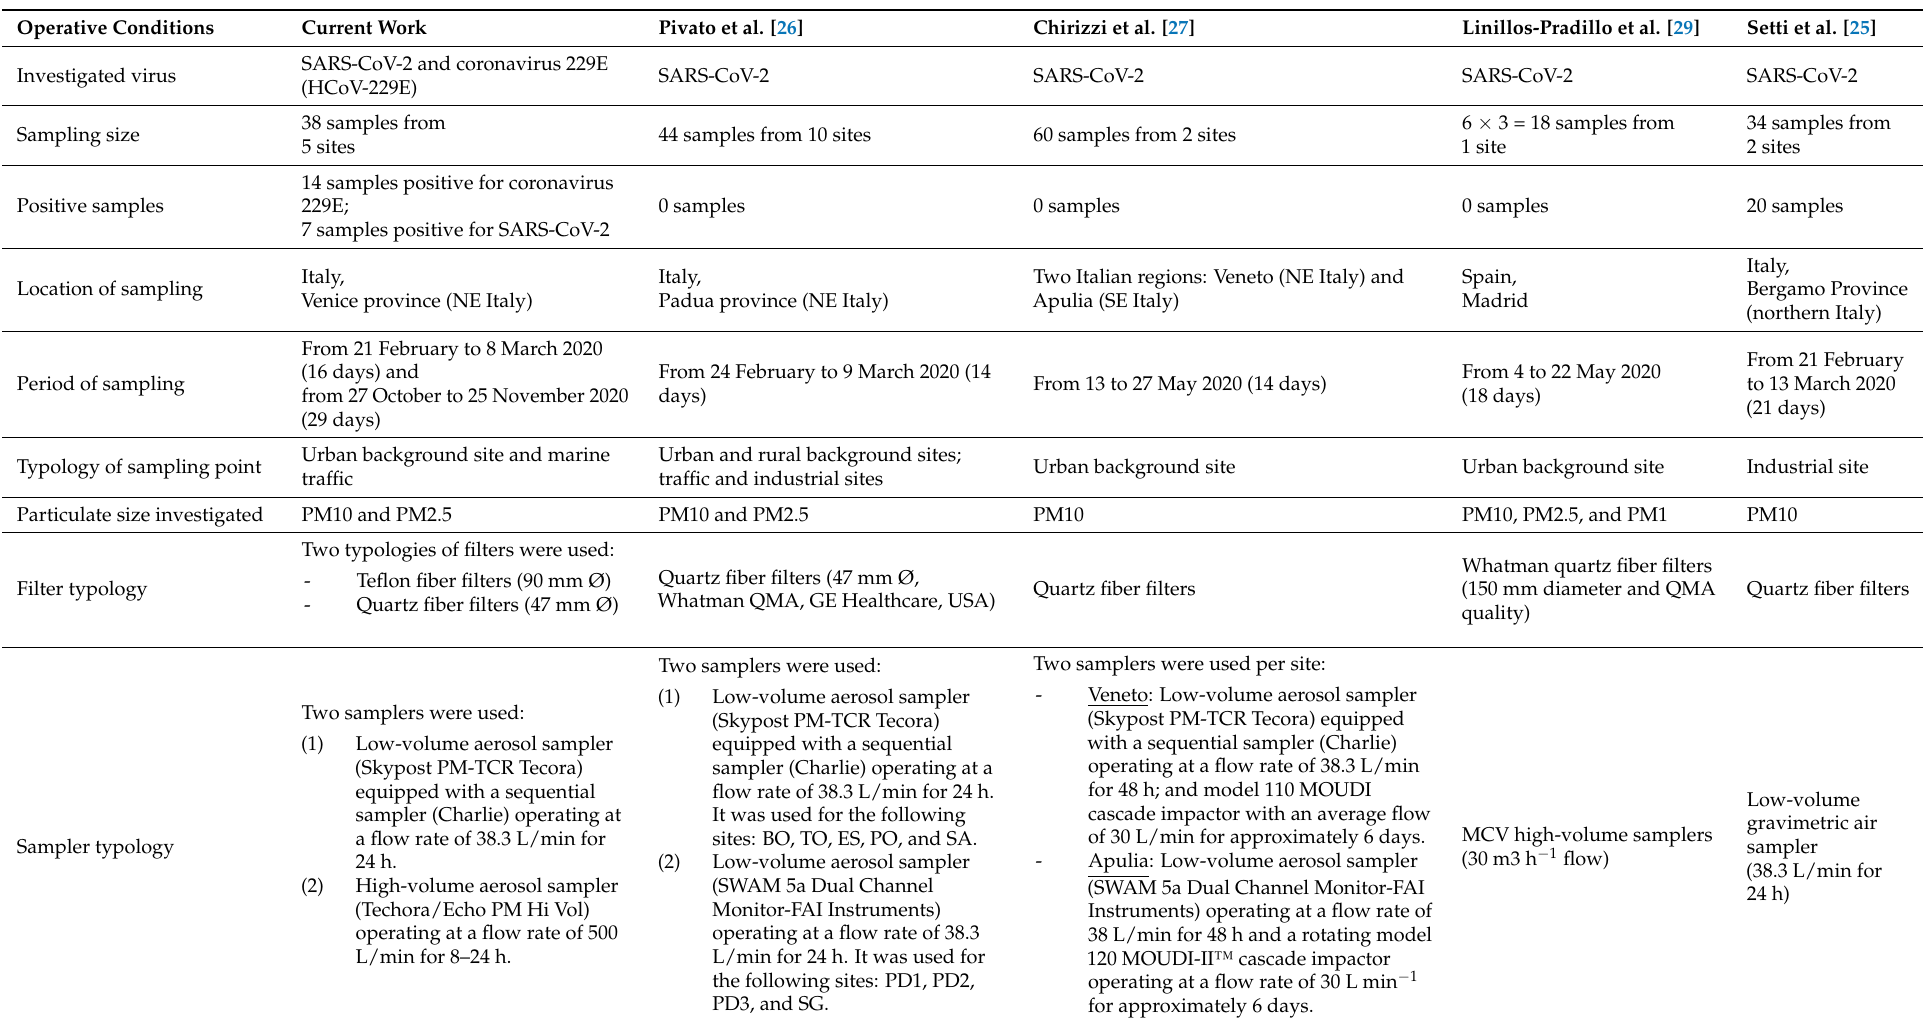
Table 1. Thorough comparison of the materials and methods used in the current study with those previously proposed by other authors